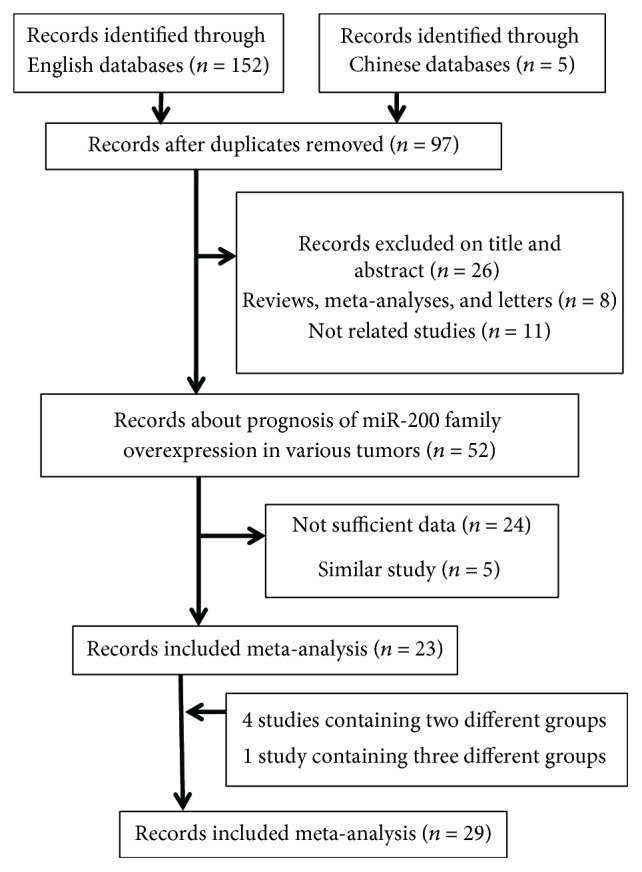
Flow diagram of the study selection process in the meta-analysis.